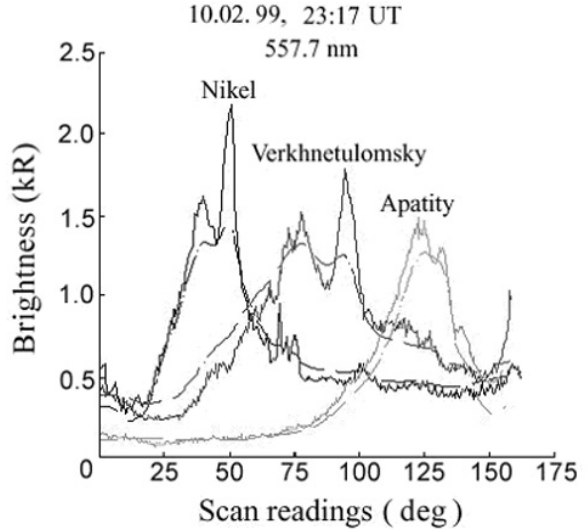
Fig. 3. Luminosity records obtained at the sites at the same time during quiet geomagnetic conditions. The measured records are shown as the solid lines, and the corresponding smoothed dashed lines represent the values obtained from the tomographic recon-